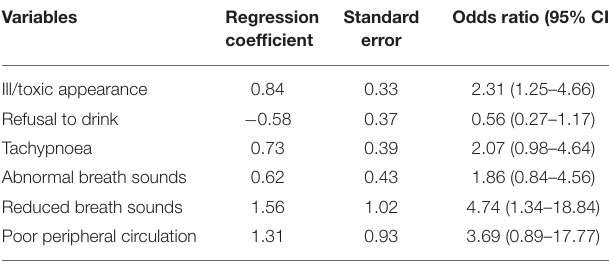
TABLE 3 | Frequency of predictor variables in derivation population. TABLE 4 | Variables of clinical prediction model